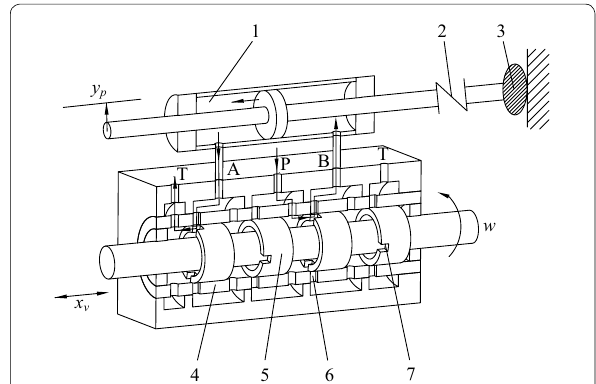
Figure 16 2D-valve controlled high-frequency electro-hydraulic vibration equipment. 1. Hydraulic cylinder; 2. Load sensor; 3. Load object; 4. Valve sleeve; 5. Spool; 6. Valve sleeve window; 7. Spool